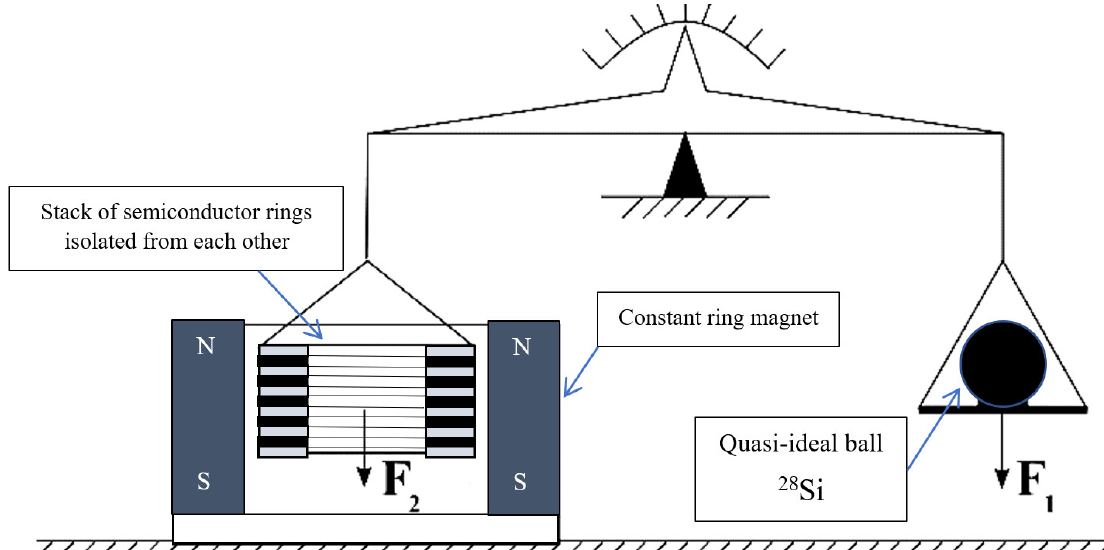
Figure 7. The scheme of thermoelectric semiconductor ampere-balances for transferring a measure of mass to a reference or exemplary measuring instrument (in particular, a quasi-ideal silicon ball).